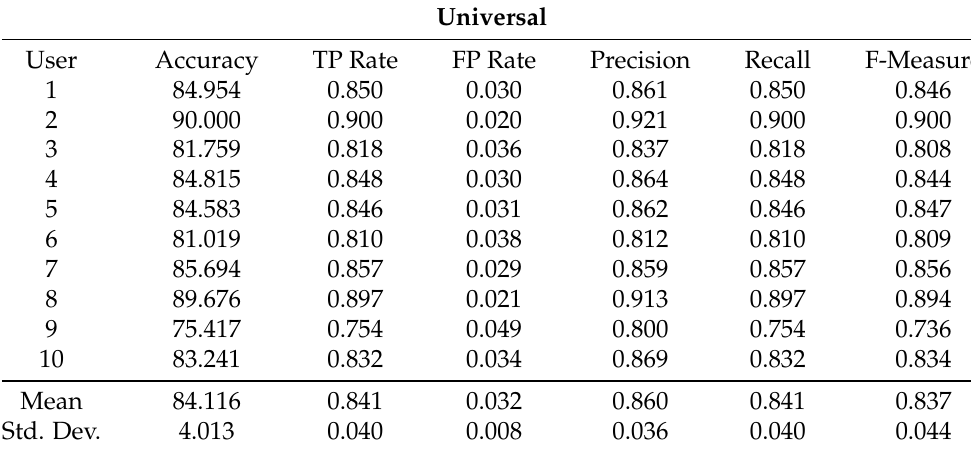
Table 4. Random Forest results for universal model in SHOAIB dataset.